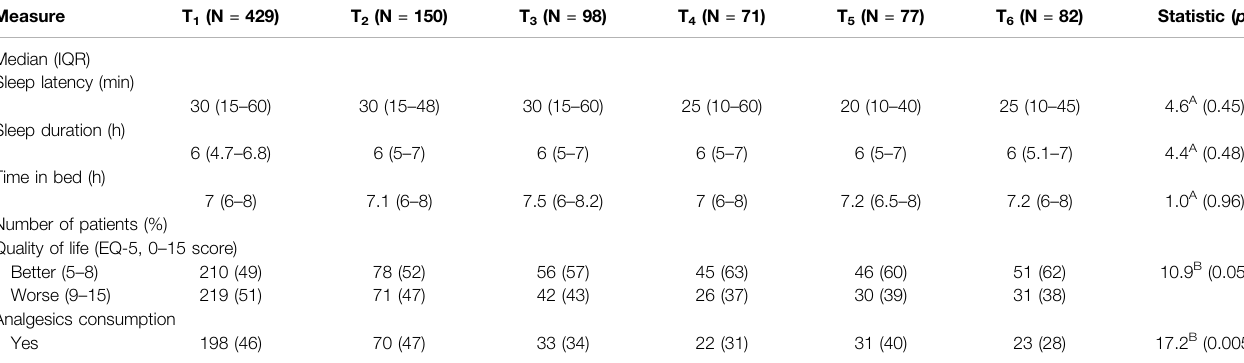
TABLE 3 | Sleep timing, quality of life and analgesics consumption of the study sample at one month intervals within a six-month period. Measure T 1 (N =